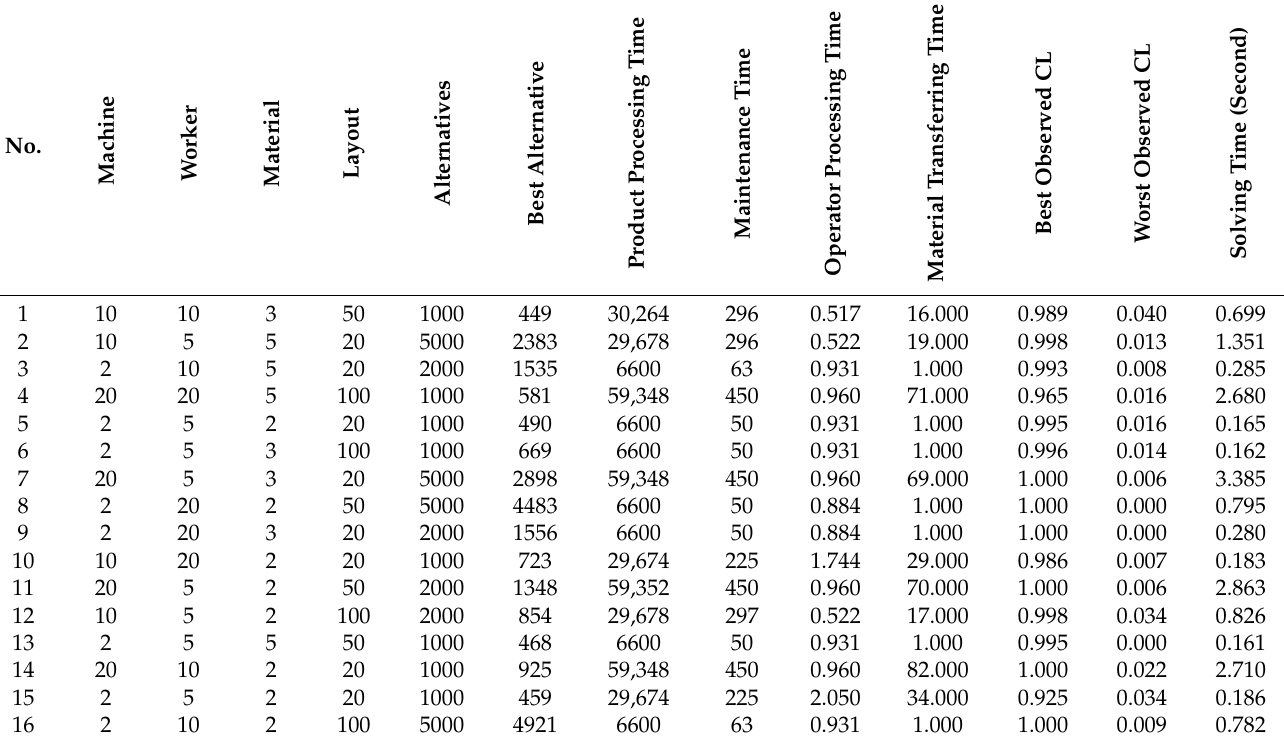
Table 10. Results of solving numerical experiments using the proposed hybrid fuzzy-TOPIS